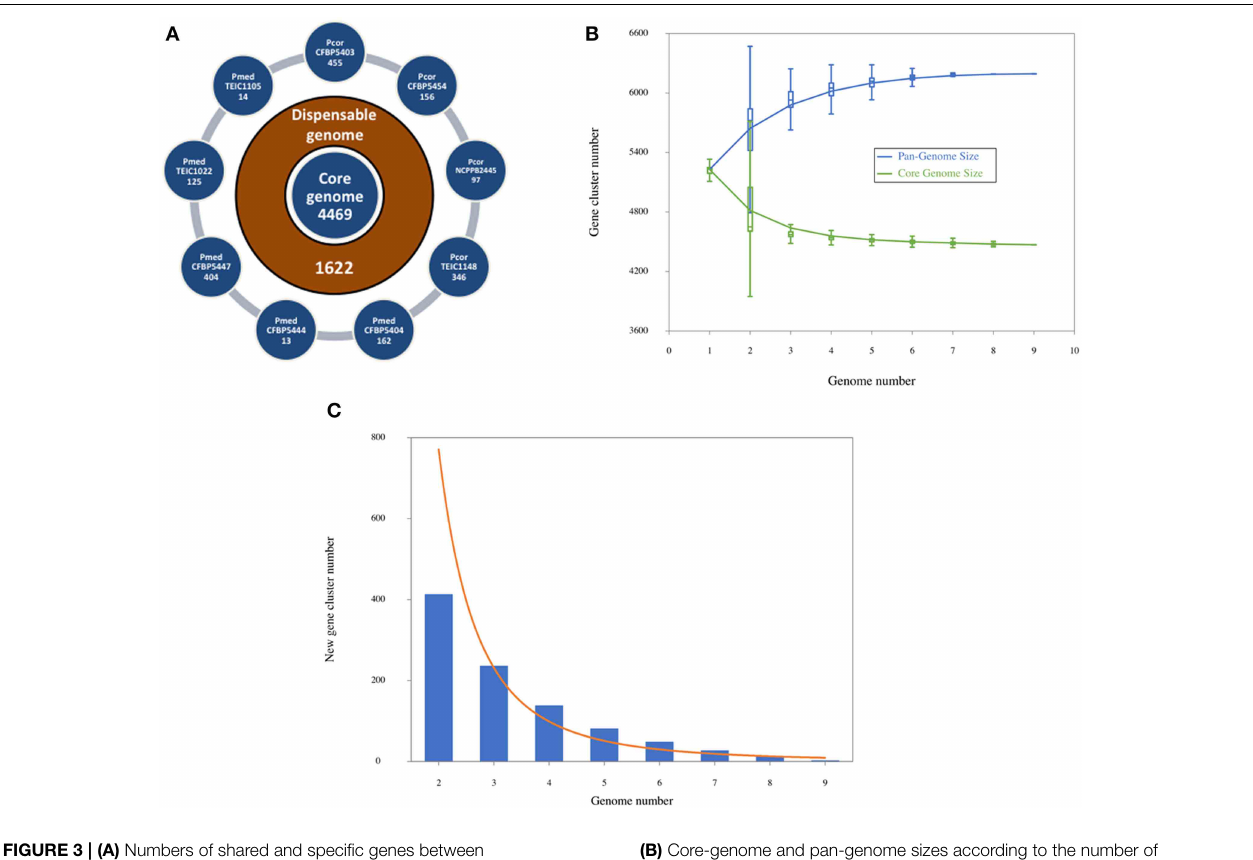
FIGURE 3 | (A) Numbers of shared and specific genes between Pseudomonas corrugata and P. mediterranea based on clusters. External circles show singletons of each genome. The intermediate circle shows the number of dispensable genes, and the inner one shows the core genome size, given by the number of clusters with at least one gene of each